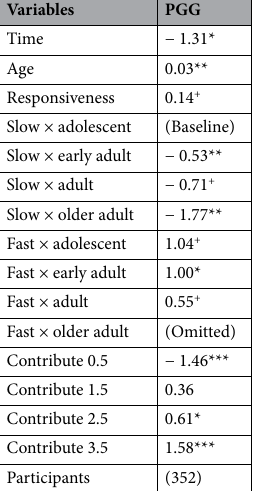
Table 12. Ordered probit estimates for specification (3) with responsiveness as an additional regressor. + p < 0.15 (marginally significant), *p < 0.05, **p < 0.01, ***p < 0.001.